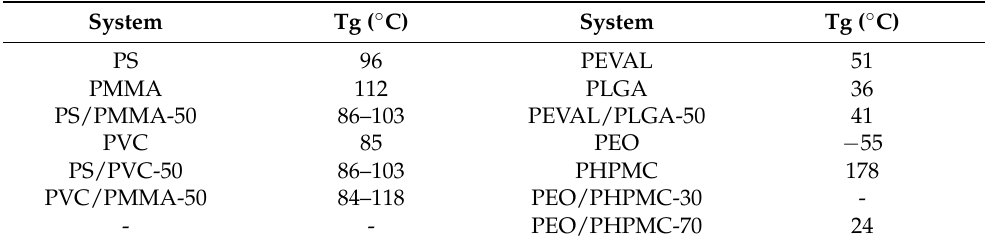
Table 1. Glass transition temperatures of PS/PMMA-50, PS/PVC-50, PVC/PMMA-50, PEVAL-PLGA- 50, PEO/PHPMC-30, and PEO/PHPMC-70 blends and their pure components.